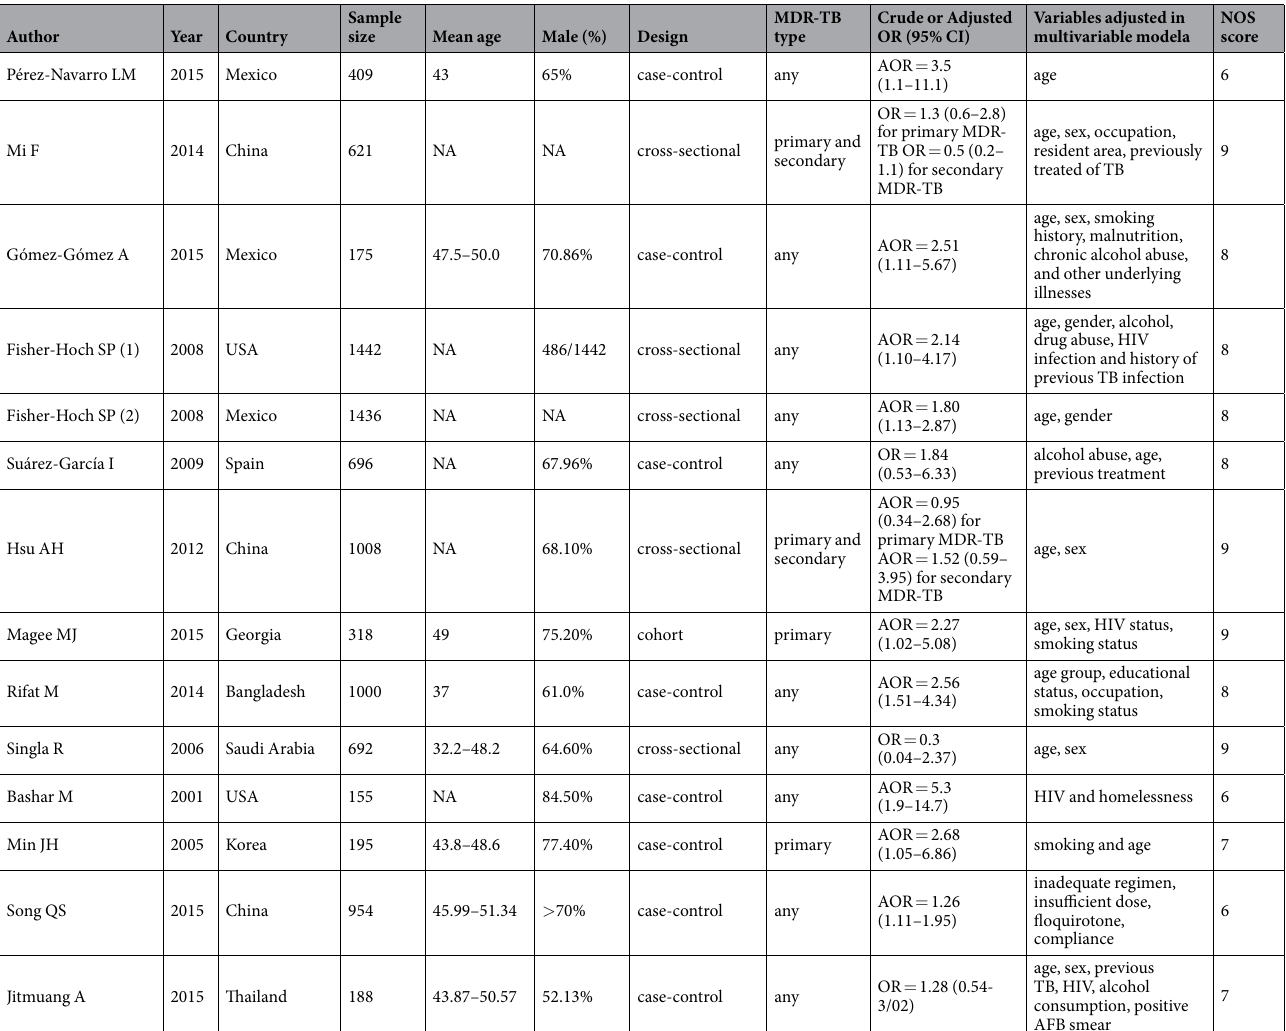
Table 1. Characteristics of studies included in the meta-analysis. Abbreviations: MDR-TB, multidrug resistant tuberculosis; OR, odds ratio; CI, confidence interval; AOR, adjusted odds ratio; NA, not available; TB, tuberculosis; HIV, human immunodeficiency virus; AFB, acid-fast